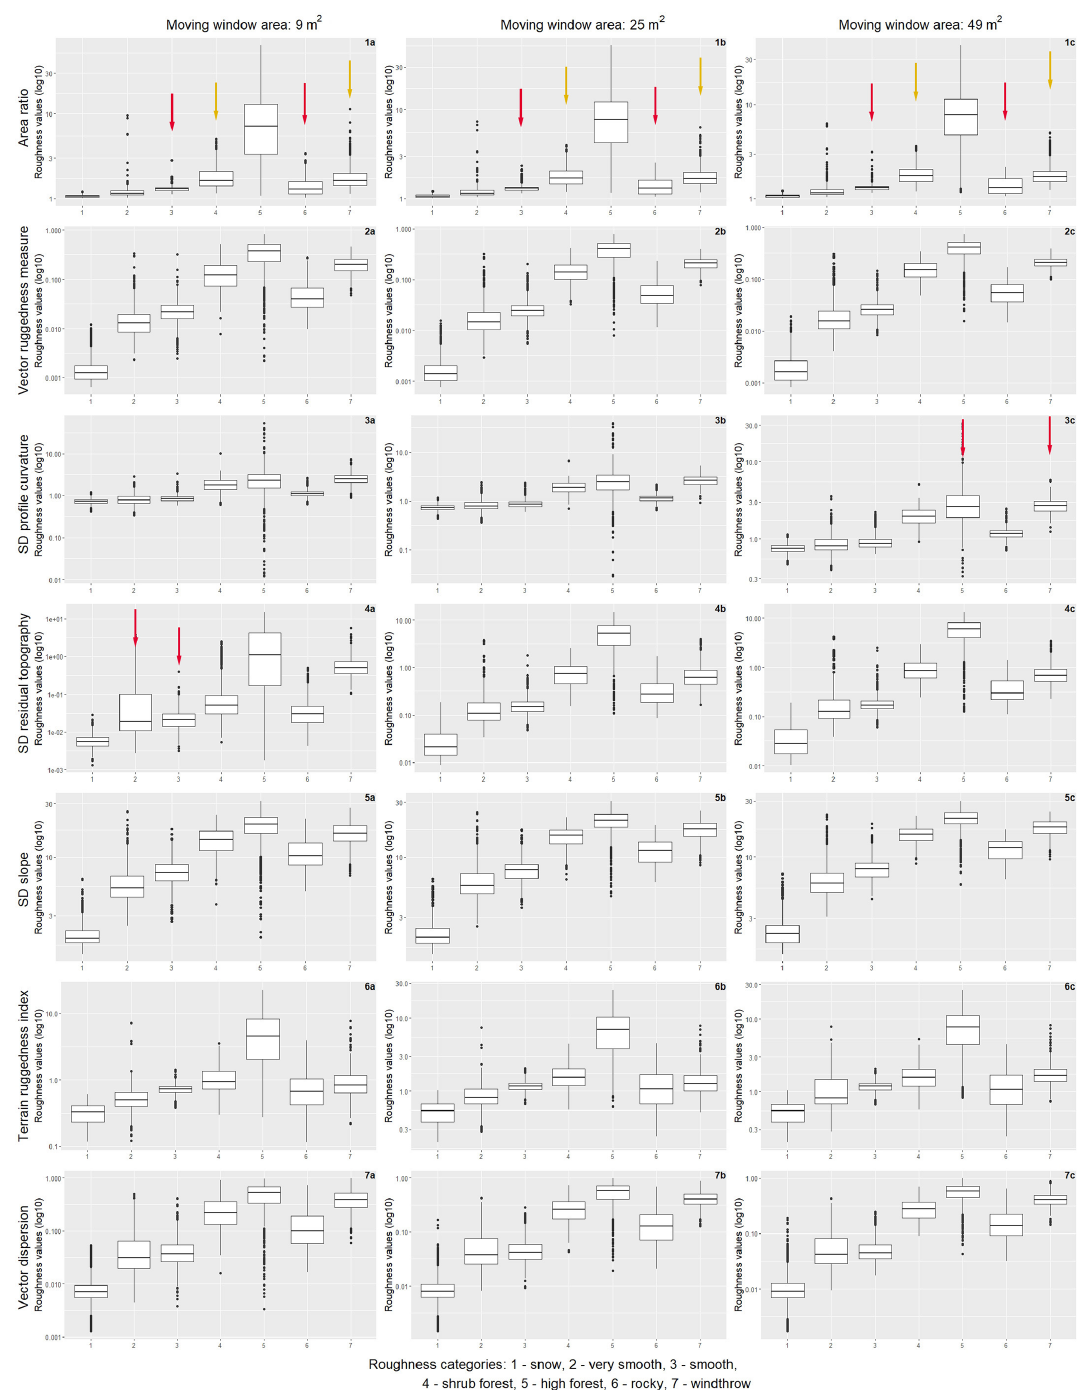
Figure A1. Distribution of roughness values according to different roughness categories (1 – snow, 2 – very smooth, 3 – smooth, 4 – shrub forest, 5 – high forest, 6 – rocky, 7 – windthrow) for seven algorithms (area ratio, vector ruggedness measure, SD of profile curvature, SD of residual topography, SD of slope, terrain ruggedness index and vector dispersion) for the spatial resolution of 0.1m. Red and yellow arrows show the overlapping distribution for a pair of categories that the given algorithm fails to